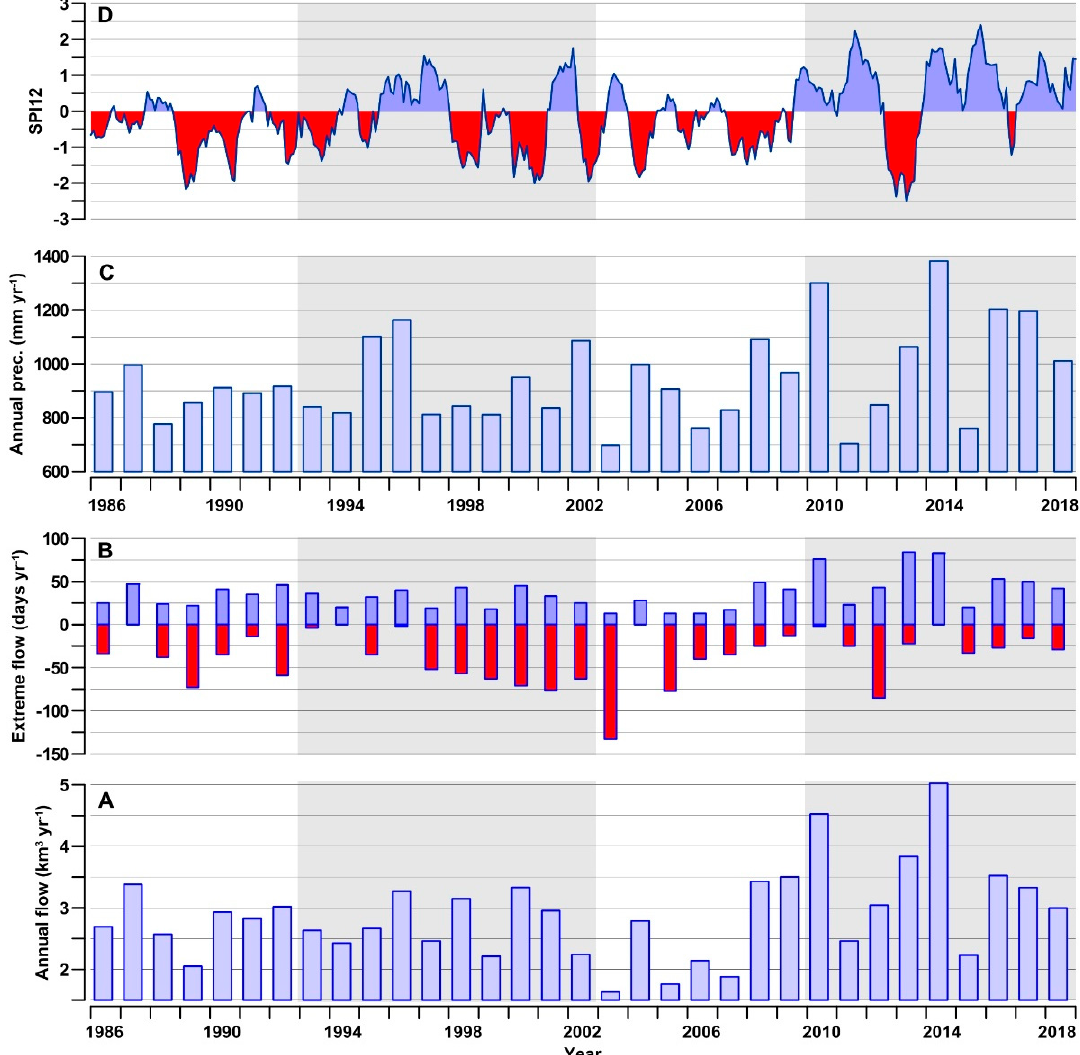
Figure 5. ( A ) Annual flow (km 3 yr − 1 ) of Isonzo River in 1986–2018. ( B ) Number of days with extremely low (red; <10th percentile) and high (blue; >90th percentile) river flow. ( C ) Annual precipitation at sea surface in the GoT (mm yr − 1 ). ( D ) Standard Precipitation Index calculated over 12-month periods (SPI12) by monthly precipitation data ( − 3 = extremely dry, 3 = extremely wet). Gray and white areas indicate the major phases of phytoplankton dynamics shown in Section 3.1.